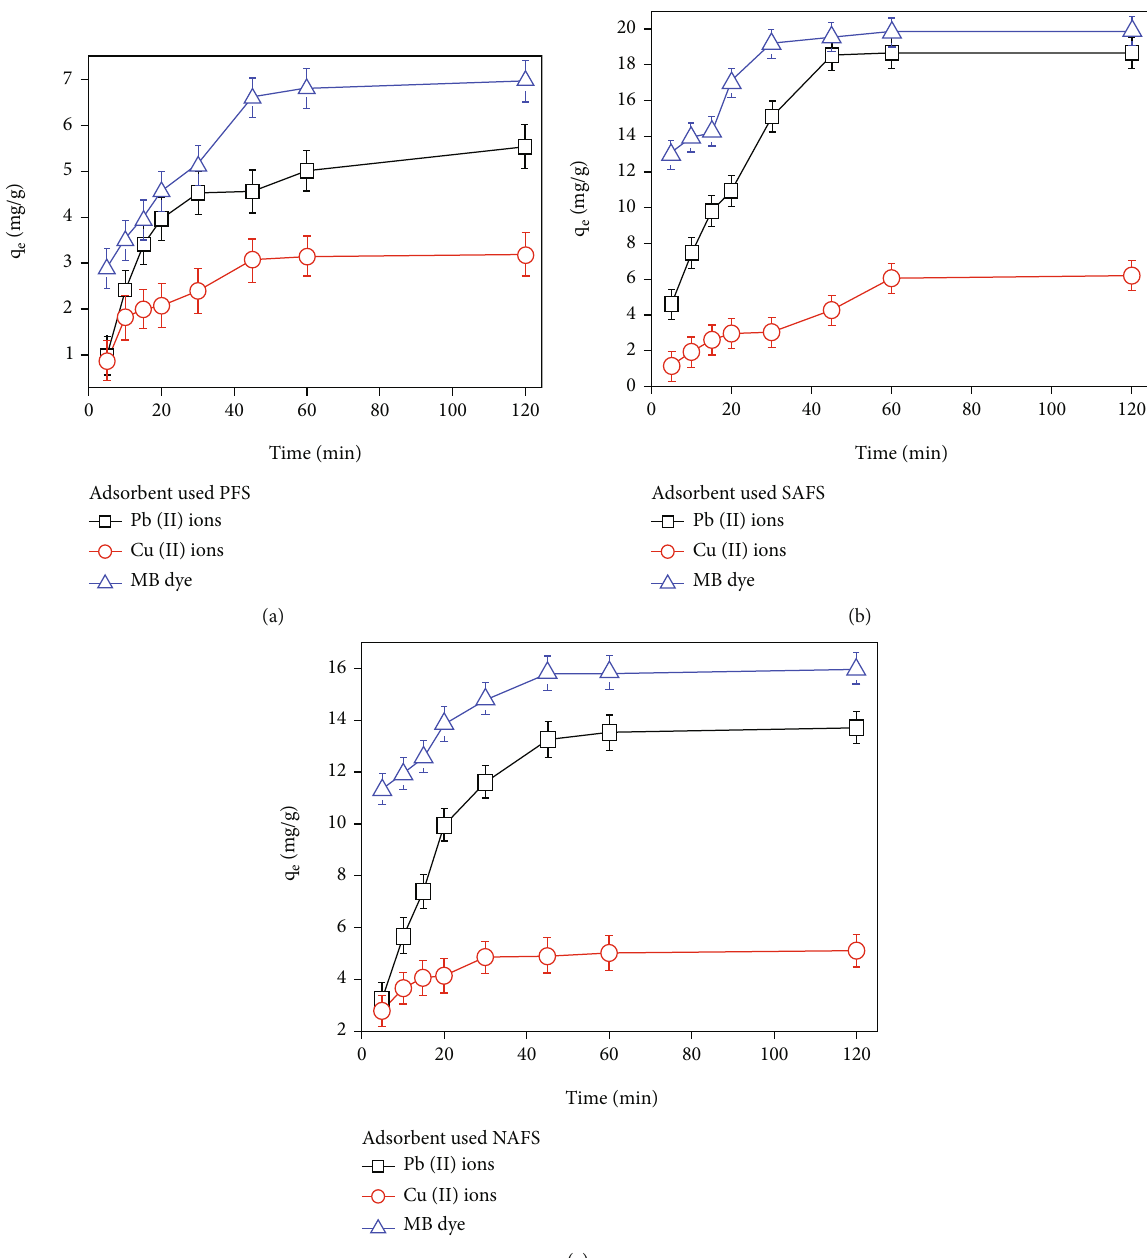
Figure 6: Time e ff ect studies on the adsorption of Pb(II), Cu(II), and MB onto pure (a) PFS and treated (b) SAFS and (c) NAFS fennel seed adsorbents (system parameters: temperature = 298 K, pH = 7, workingsolution = 100 mg/L, andadsorbent mass = 10mg